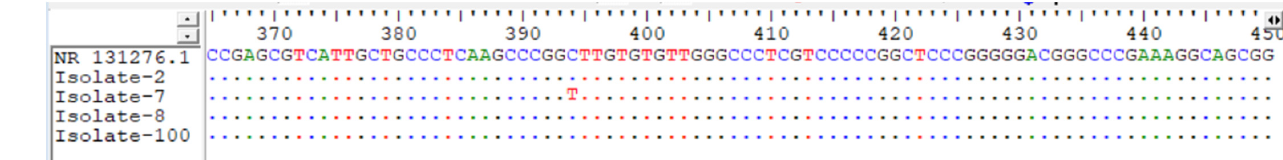
Figure 2. A difference of single nucleotide base between A. terreus clinical isolate and reference strain. The analysis was done using the BioEdit alignment editor v7.2.5.